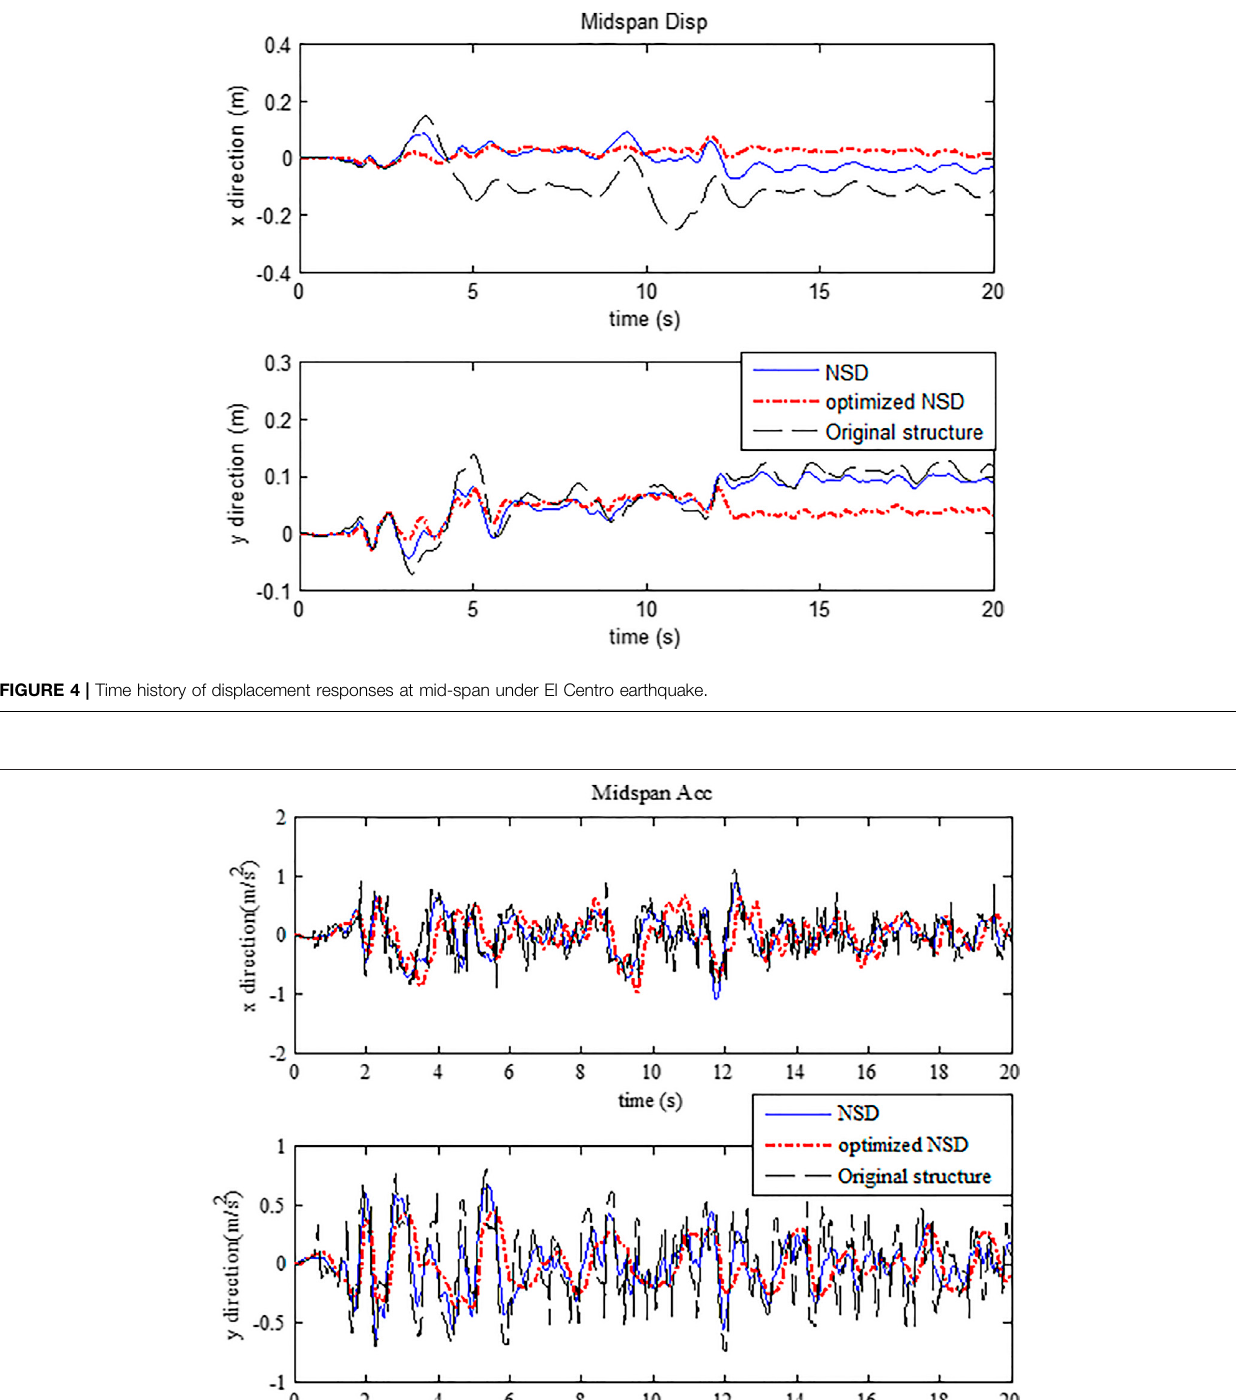
Frontiers in Physics |